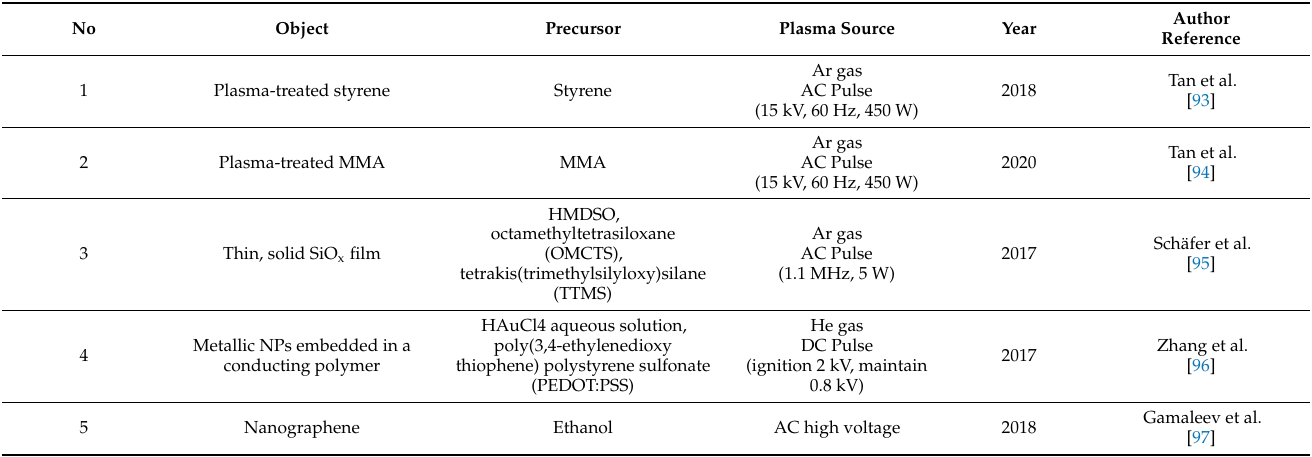
Figure 9. Schematics of generation of the on-solution plasma systems of ( a, b ) Tan et al. [93,94], ( c, d ) Schäfer [95] et al., ( e ) Zhang et al. [96], and ( f ) Gamaleev et al. [97]. Table 3. Summary of syntheses using on-solution plasma